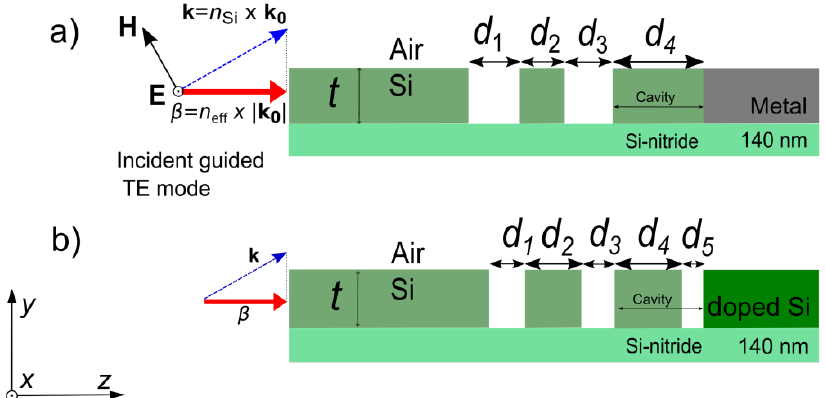
Figure 1. ( a ) Schematic illustration of a slab Tamm plasmon structure with slab height 𝑡 featuring a metal as plasmonic material. ( b ) Corresponding slab TP structure featuring strongly doped silicon as plasmonic material and an additional airgap with width 𝑑 5 . The incident guided mode with effective index 𝑛 eff is TE polarized (i.e., electric field is out-of-plane).